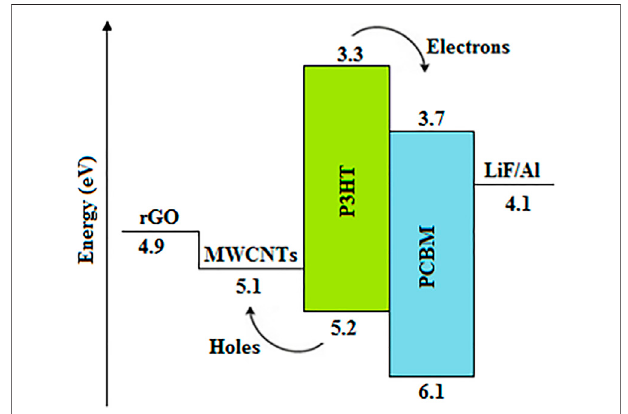
FIGURE 6 | Schematic energy level diagram of the P3HT:PCBM: MWCNT active layer-based OSC.